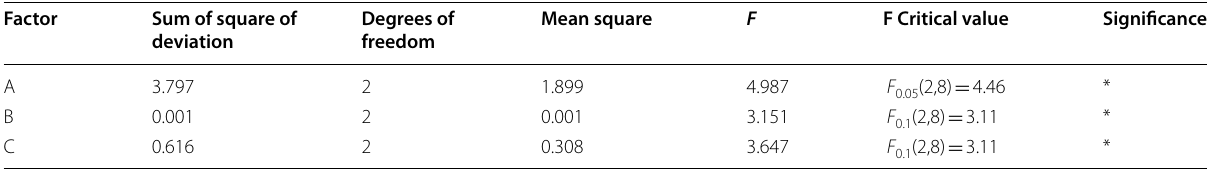
Table 13 ANOVA of the results of the 21 d compressive strength test Factor Sum of square of Degrees of Mean square deviation freedom